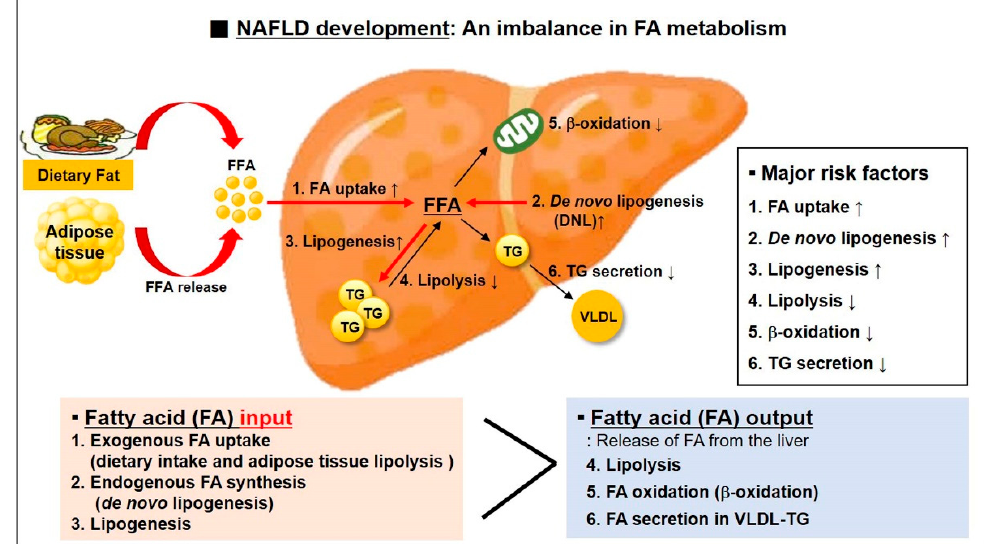
Figure 2. NAFLD development is caused by an imbalance in the intrahepatocellular fatty acid (FA) metabolism. Hepatic TG accumulation is promoted when the FA input is greater than the FA output in the liver. The greater part of FA taken up by liver is mainly derived from the lipolysis of subcutaneous adipose tissue TG. Another major source of FA in the liver is derived from de novo lipogenesis that converts excess glucose into FAs. On the other hand, the consumption of FA is possible through the signaling pathway involved in lipolysis, β -oxidation, and TG secretion ( → : signaling pathways related with TG accumulation by FA, → : signaling pathways related with the consumption of